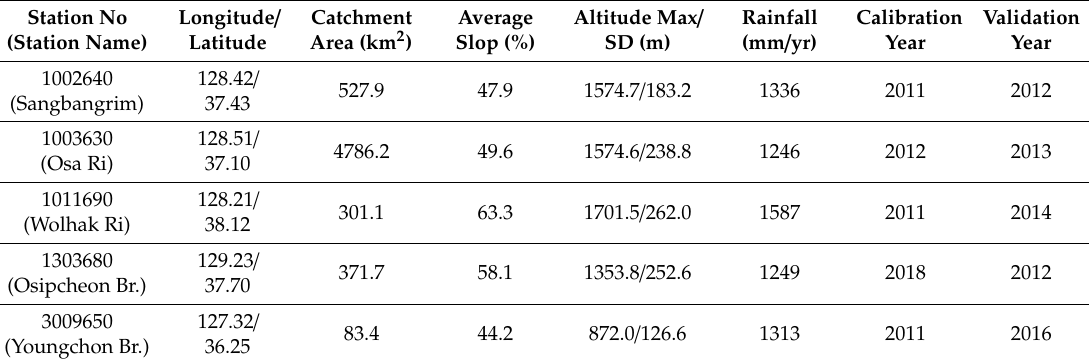
Table 1. Five calibration stations used in this study with their key geographical characteristics (catchment size, average slop, and maximum of standard deviation (SD) of altitude), annual total rainfall and years used for calibration and